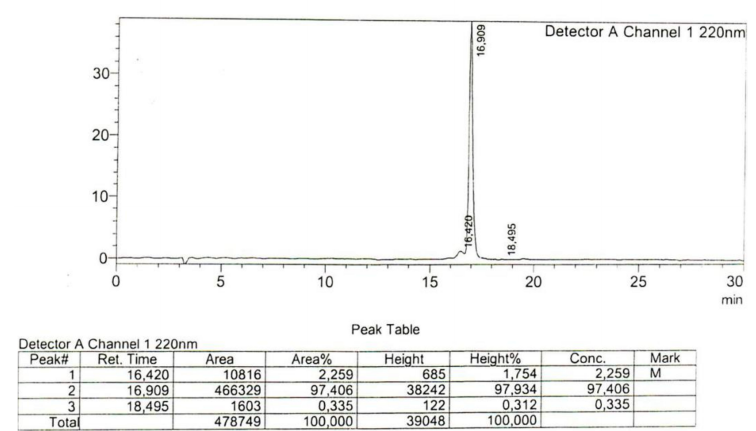
Figure A3. Analysis by high-performance liquid chromatography (HPLC) of StigA31 peptide.